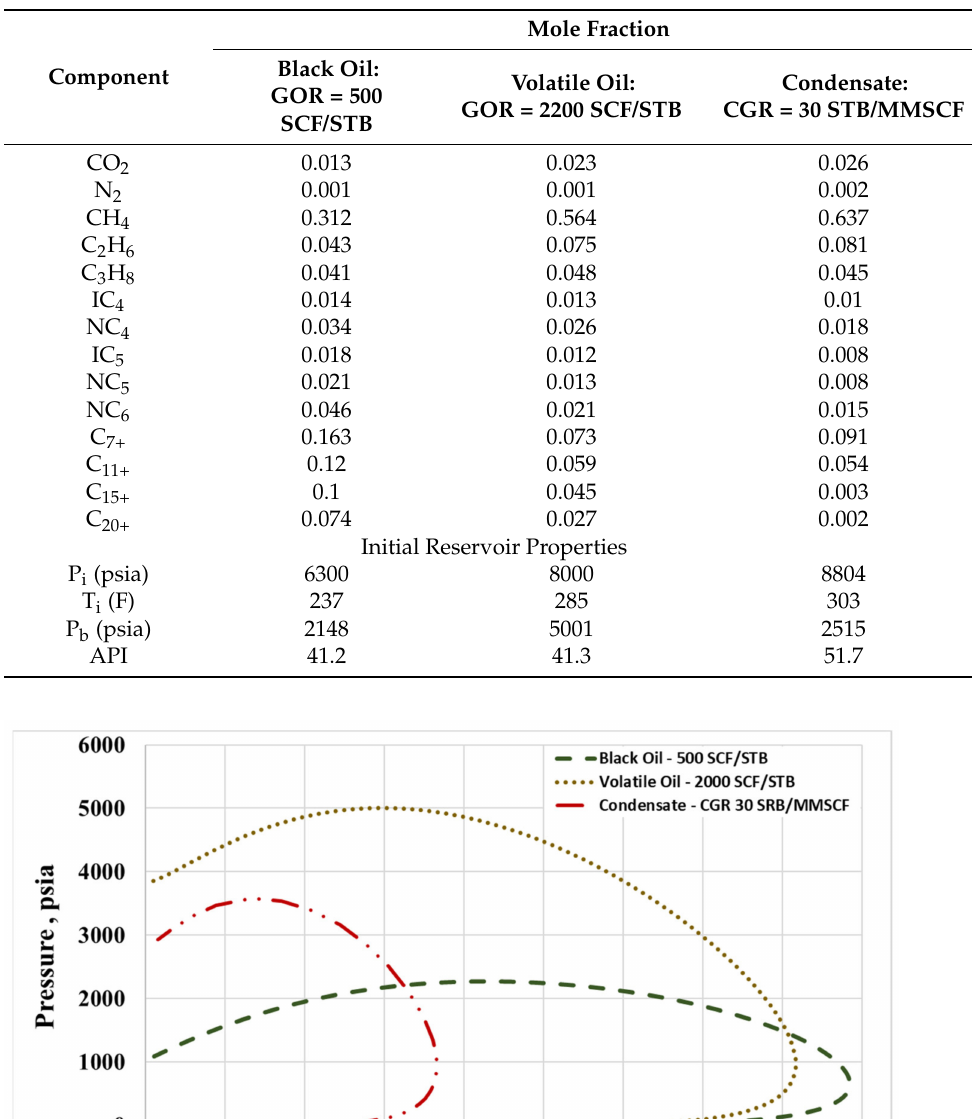
Table 2. Fluid properties and compositions of three Eagle Ford hydrocarbons, Reprint with permis- sion [29], 2011, Society of Petroleum Engineers.